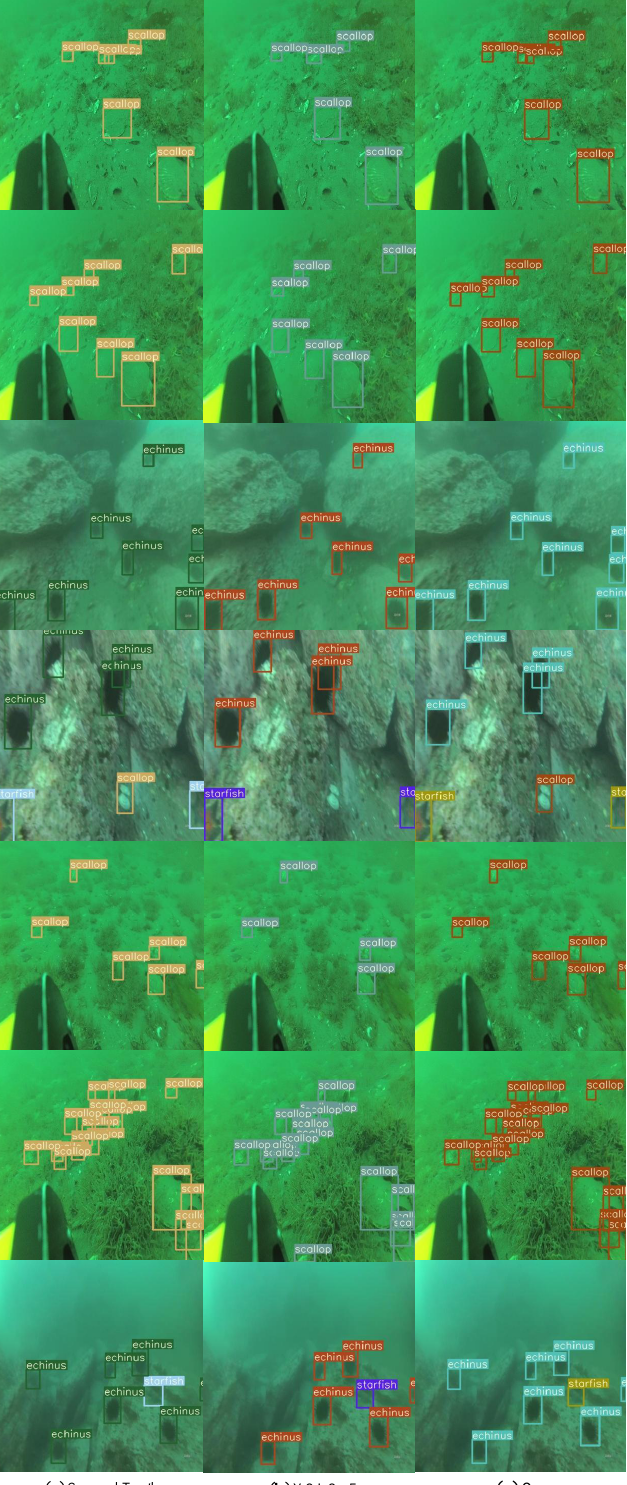
Figure 20. Underwater object-detection comparison results of YOLOv5 and improved